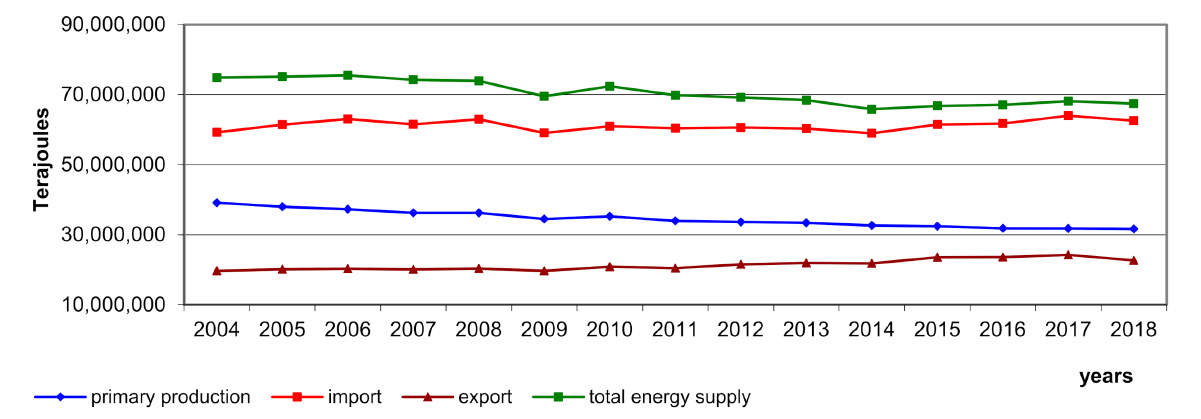
Figure 1. Primary production, import, export, and total energy supply in European Union in